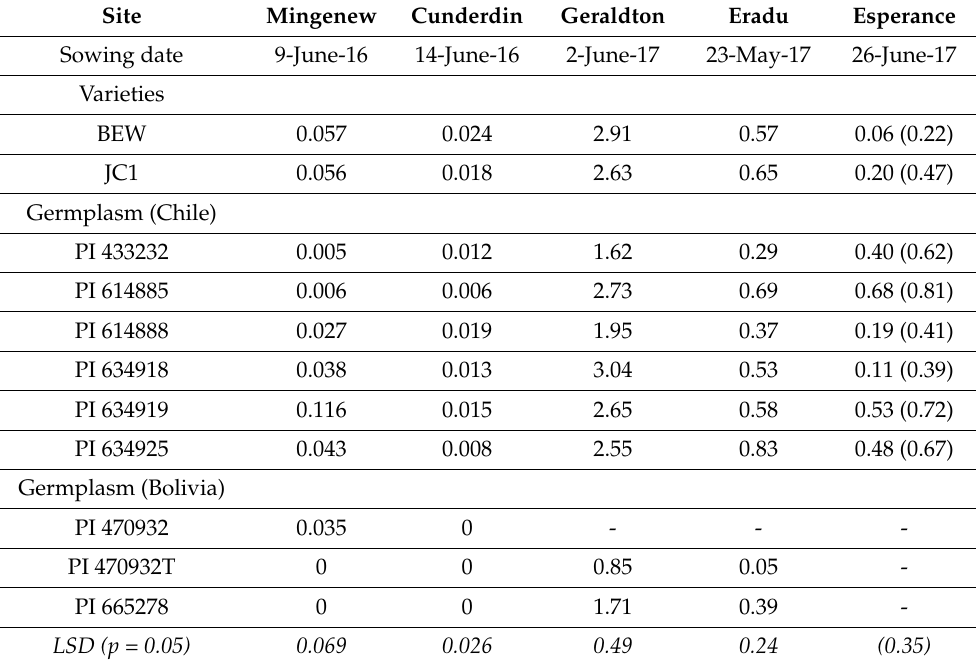
Table 9. Seed yield (t/ha) of quinoa varieties and germplasm lines at rain-fed trial sites with a hot-summer Mediterranean climate (Mingenew, Cunderdin, Geraldton, Eradu) and a warm-summer Mediterranean climate (Esperance). (Figures in brackets are square roots of yield).